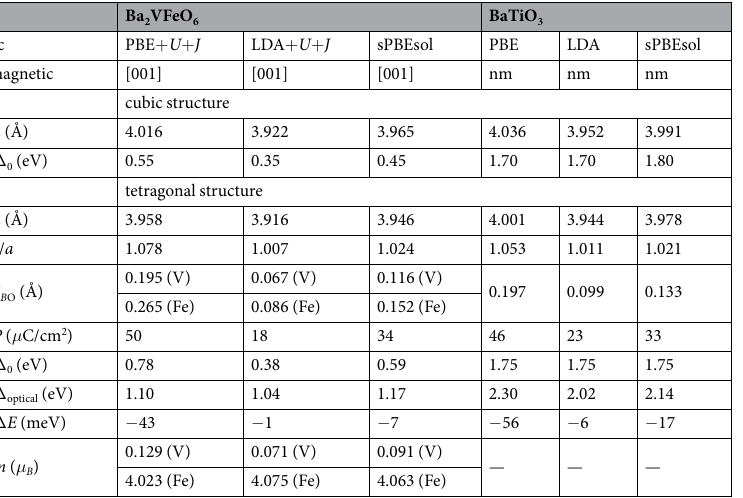
Table 1. Comparison of Ba 2 VFeO 6 and BaTiO 3 . The results are calculated using the DFT method with different exchange correlation functionals (xc). ‘nm’ stands for non-magnetic and ‘[001]’ for [001] antiferromagnetic ordering. For the cubic case, a is the lattice constant and Δ 0 is the fundamental gap. For the tetragonal case, a is the in-plane lattice constant, c / a is the ratio of out-of-plane lattice constant over in-plane lattice constant, δ B O is the B - site metal and oxygen displacement along the [001] direction. Δ 0 is the fundamental gap and Δ optical is the optical gap. Δ E is the energy difference between the tetragonal structure and the cubic structure in the unit of meV per 5-atom formula. P is the polarization along the [001] direction. m is the local magnetic moment on V and Fe